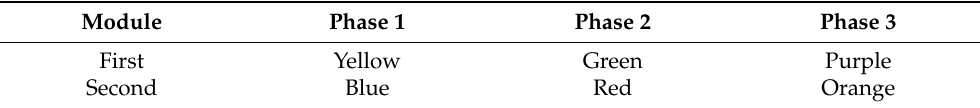
Table 2. Oscilloscope color assigned to each